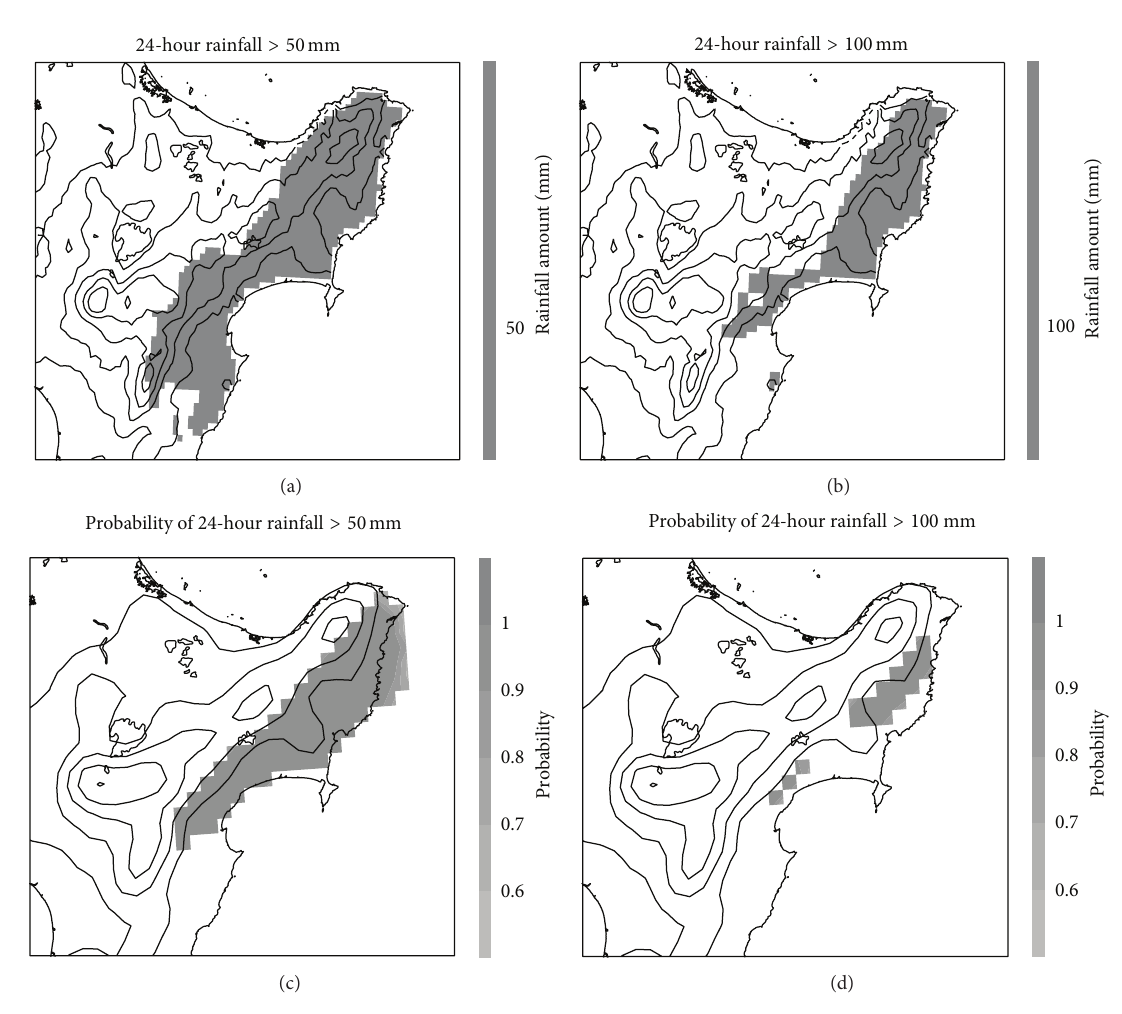
Figure 4: 24-hour rainfall amount (mm) valid at 0900 NZST 14 October 2010 greater than 50 mm (a) and 100 mm (b) from NIWA 0.05-degree grid point rainfall analysis. Occurrence probability higher than 0.6 for the corresponding forecasted 24-hour rainfall greater than 50 mm (c) and 100mm (d) with analysis at 0600 NZST. Thin solid lines denote terrain contours with a 250-meter